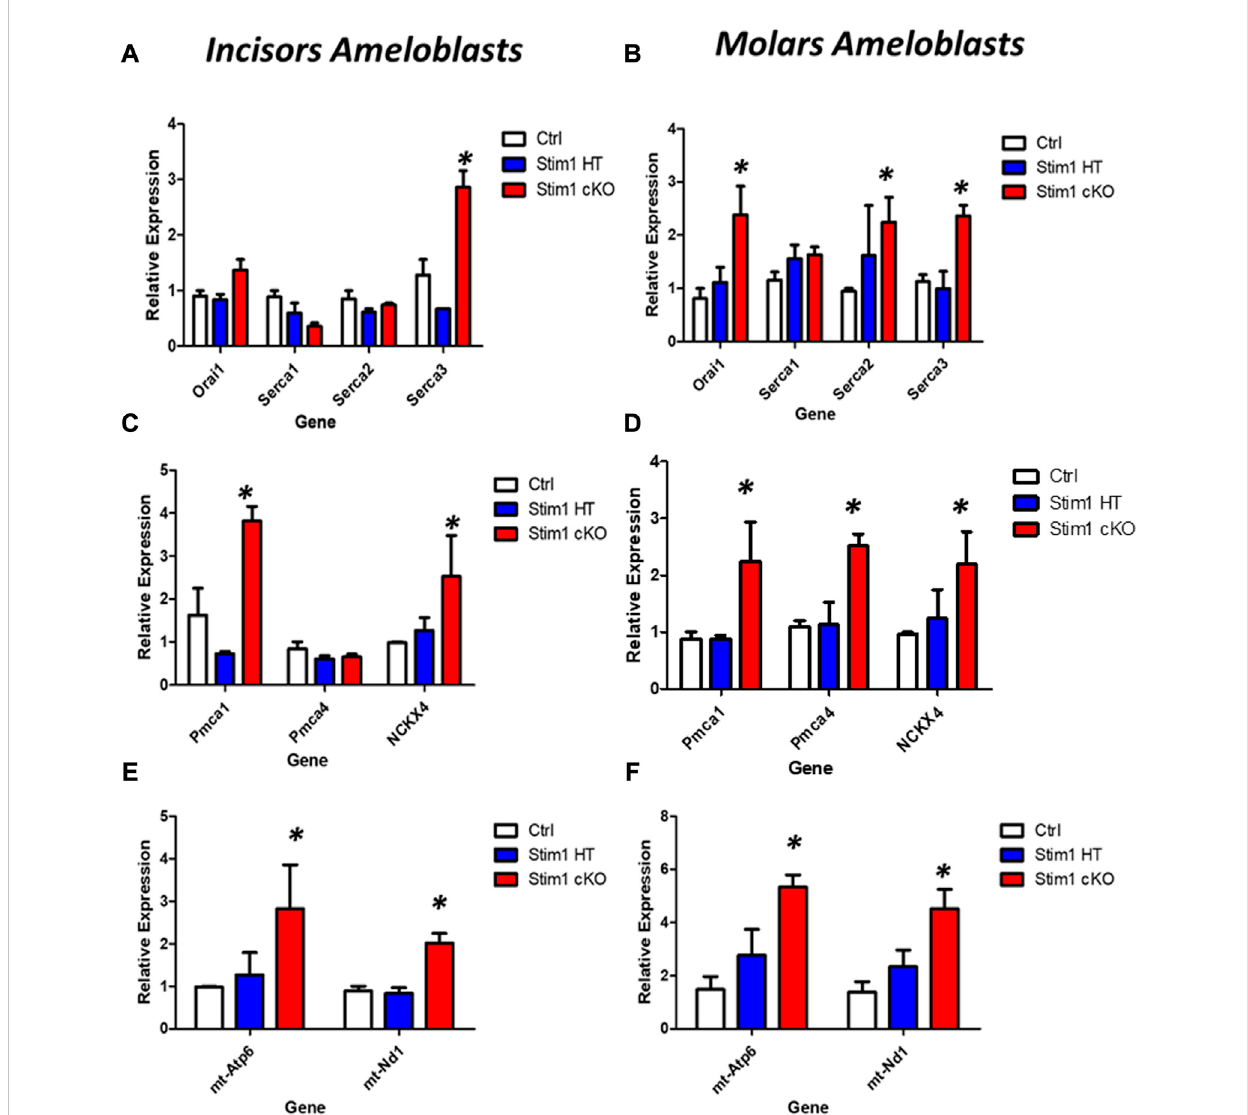
FIGURE 8 Calcium transportand mitochondrialgeneexpression analysis ofStim1 cKOmice. (A – D) Expression analysis for genesinvolvedincalciumtransport in molars and incisors ameloblasts collected from control and Stim1 cKO mice. Our RT-qPCR analysis showed that Stim1 deletion has resulted in signi fi cant upregulation of several genes encoding proteins that are essential for SOCE and transcellular calcium transport during amelogenesis. These changes appear to be more pronounced in molars ’ ameloblasts as the 7 genes we investigated molars Stim1 cKO ameloblasts had a signi fi cantly higher expression of 6 genes (SECA2, SERCA3, NCKX4, PMCA1 and PMCA4) compared to control (genes encoding ORAI1, SERCA1,2,3, PMCA1,4 and NCKX 4) while Stim1 cKO incisors ameloblasts displayed a signi fi cantly higher expression of three genes involved in calcium transport (SERCA3, NCKX4 and PMCA1) compared to control. Similar to the genes encoding the enamel matrix proteins, no clear differences were found between the Stim1 HT and Stim1 Ctrl in the expression of the seven genes. (E,F) Expression analysis for the mitochondrial genes (mt-Atp6 and mt-Nd1) in molars and incisors ameloblasts collected from control and Stim1 cKO mice. The expression levels of both mitochondrial genes were signi fi cantly upregulated in Stim1cKOameloblastscomparedtocontrolsinbothincisorandmolarameloblasts.However,thedegreeofupregulationwasmoresigni fi cantinMolars ’ ameloblasts. No clear differences were found between the Stim1 HT and Stim1 Ctrl in the expressions of these mitochondrial genes (mean ± SEM, n = 3~4 mice per genotype; * p < 0.05 compared to